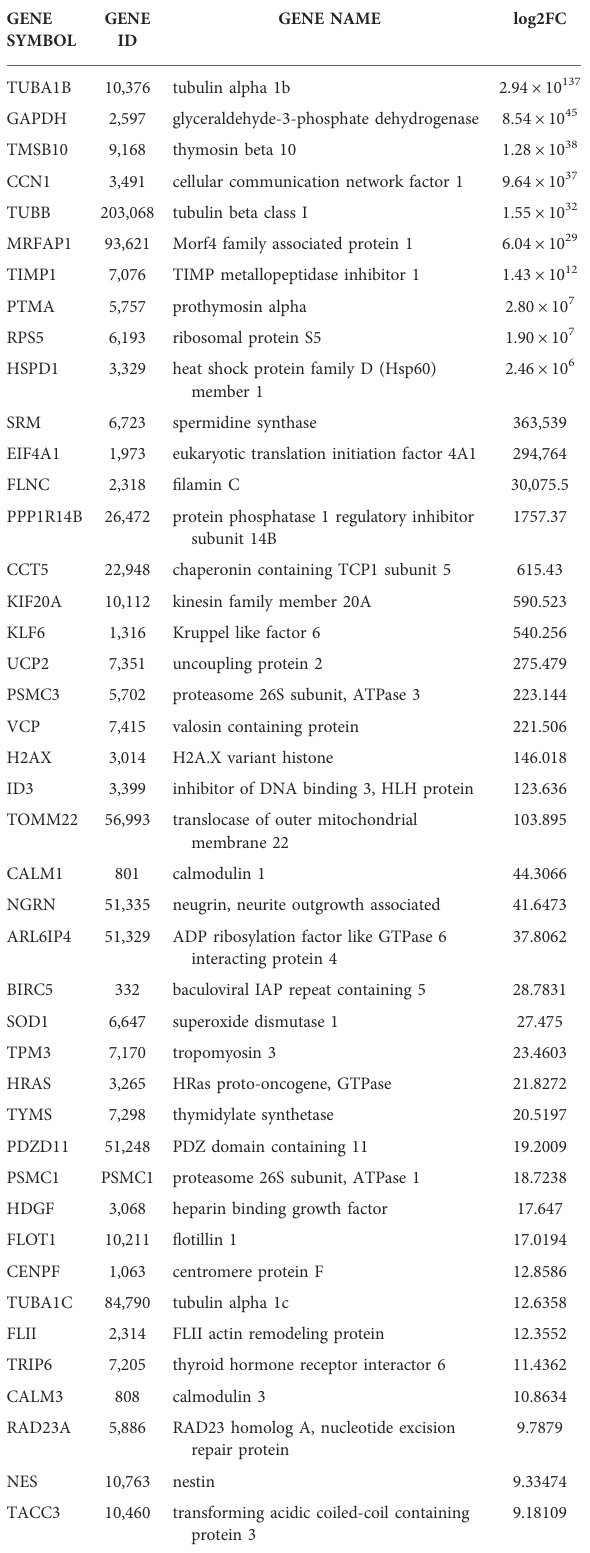
TABLE 3 Top 50 upregulated genes with>5 log2FC and ≤ 0.05 FDR in SRC-2 knockdown THESCs